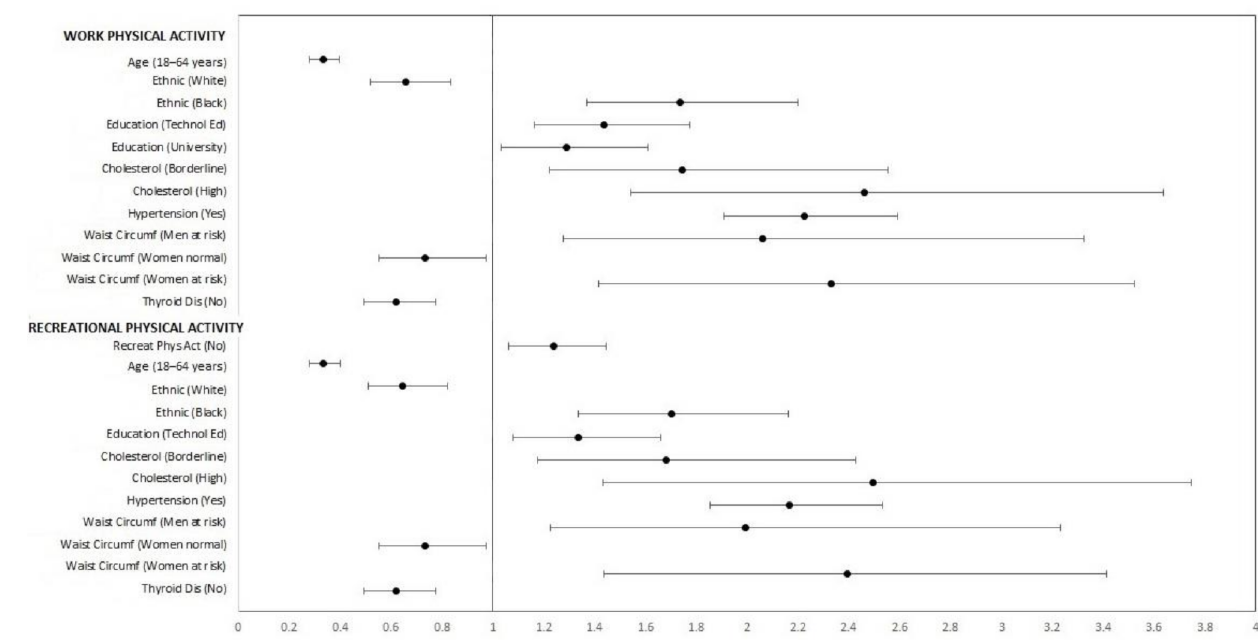
Figure 1. Forest plot of the multivariate adjusted model of significant odd ratios for work/recreational physical activity and prediabetes, in U.S. adults from NHANES